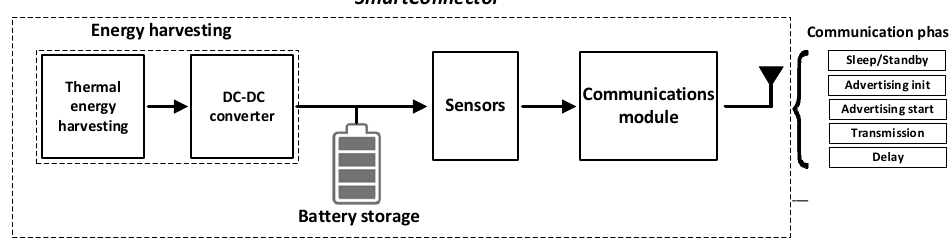
Figure 1. Diagram of the wireless SmartConnector device.